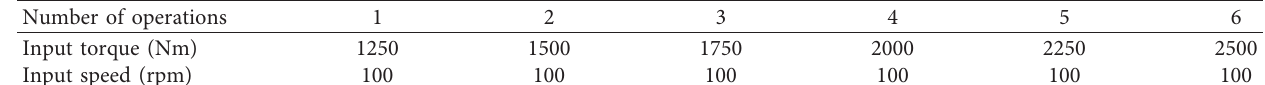
Table 2: Operating conditions.